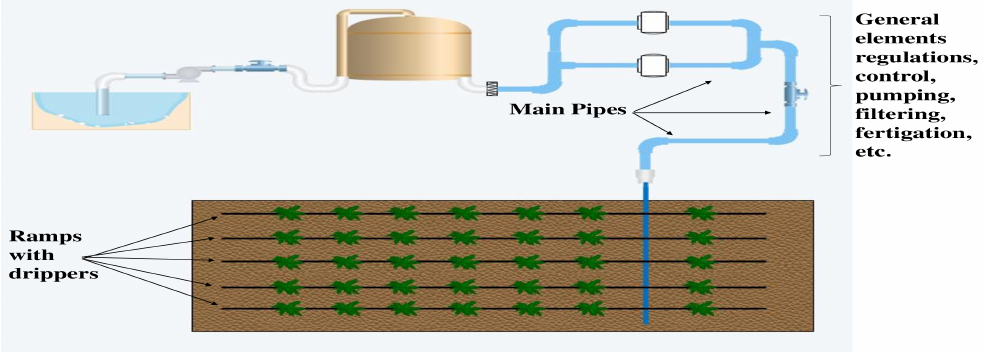
Figure 1. Typical drip system